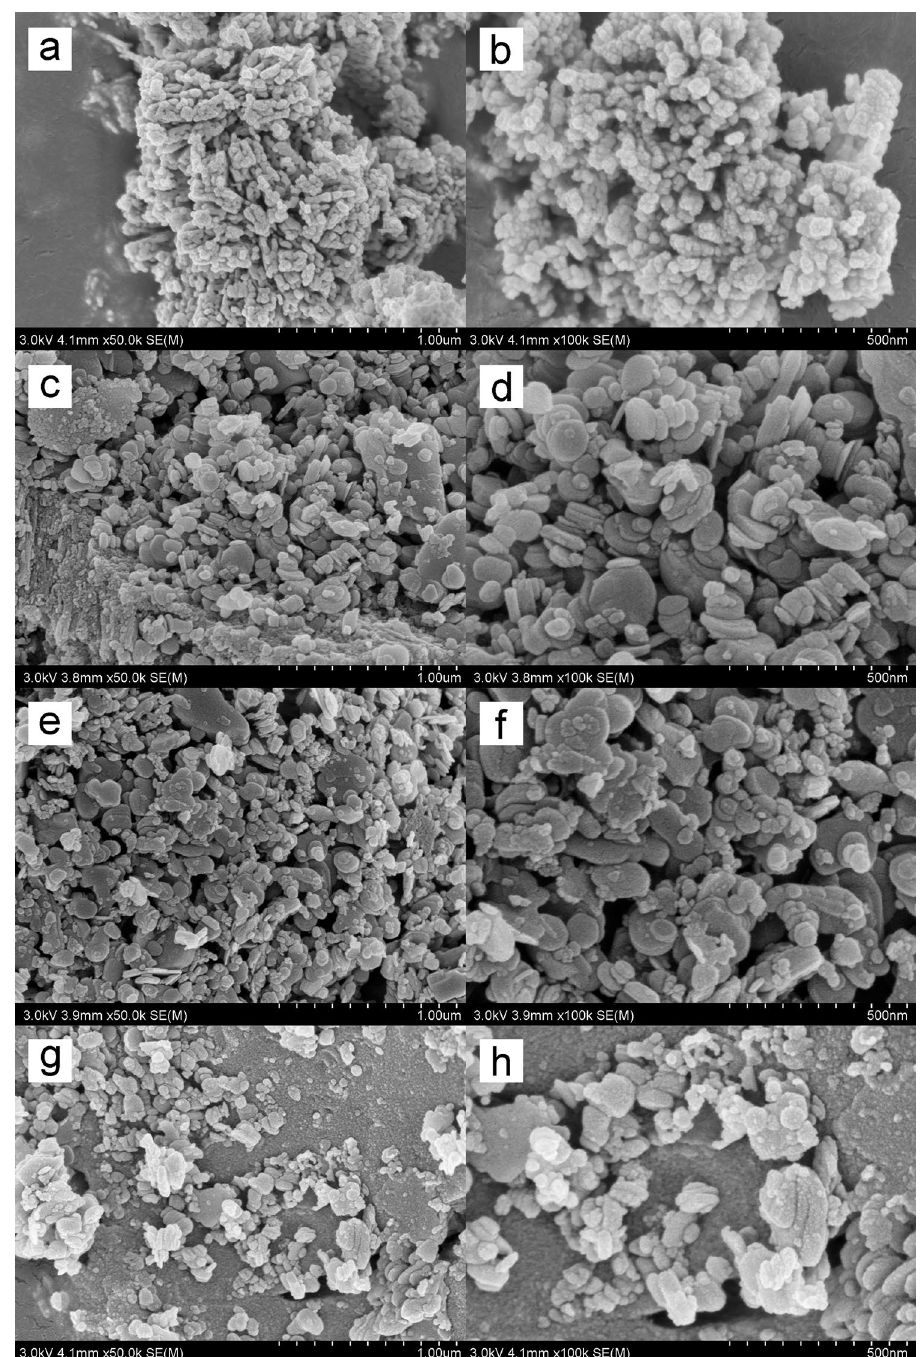
Fig.5 SEM images of CuO ( a , b ), h-BN ( c , d ), BNNS ( e , f ) and CuO@BNNS ( g , h